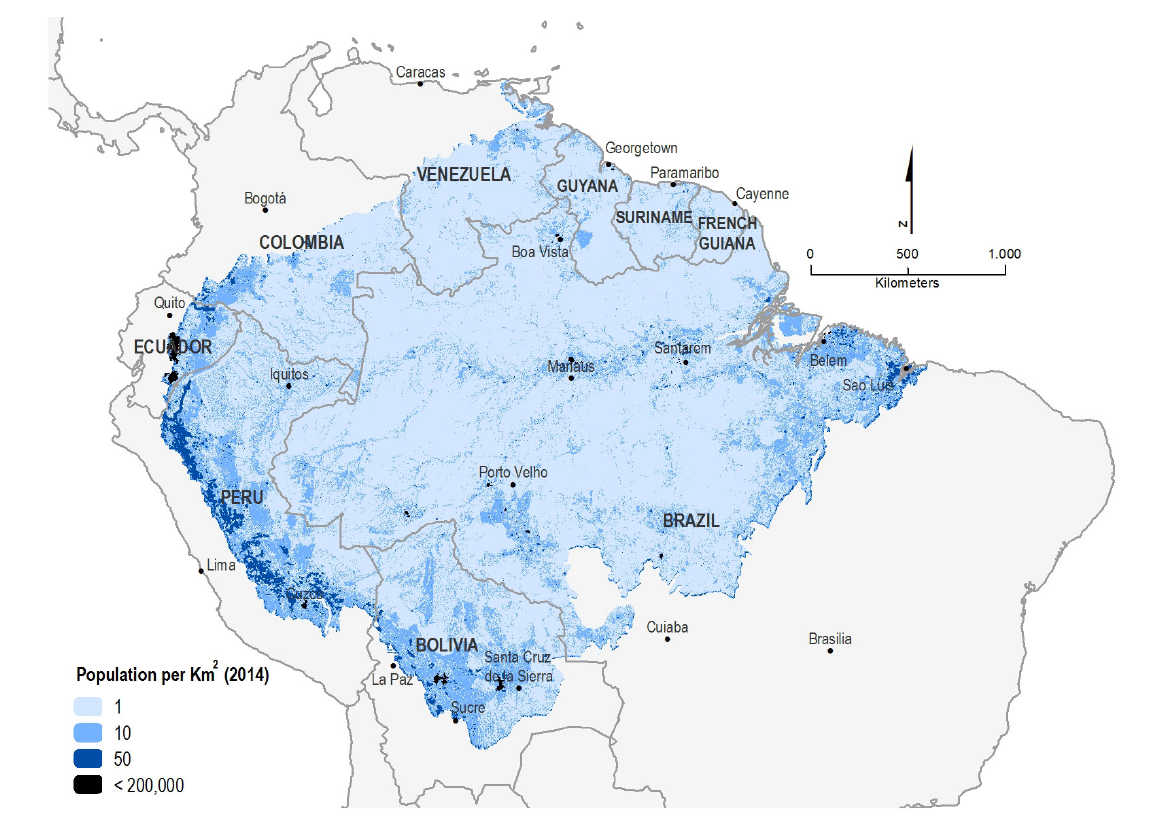
Fig. 6 . Settlement patterns in the Amazon. Source: Modified from Neugarten et al.